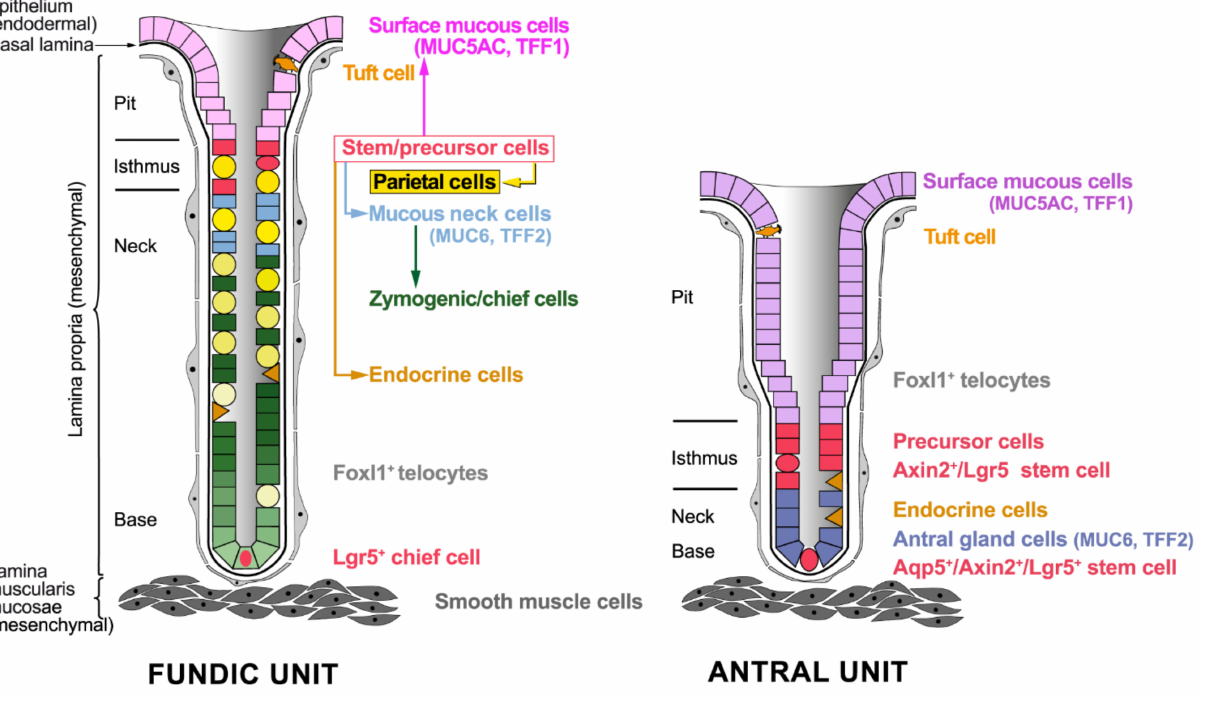
Figure 1. Schematic representation of the gastric mucosa and the two gross types of gastric units in the fundus/corpus and cardia, antrum/pylorus, respectively. A gastric unit consists of the pit (or foveola) and the gland (i.e., isthmus, neck, and base). Shown are the major epithelial (surface mucous, parietal, mucous neck, zymogenic/chief, endocrine, and antral gland cells) and mesenchymal cell types (Foxl1 + subepithelial telocytes, smooth muscle cells). The various gastric stem and precursor cells are marked in red. Additionally, figured are rare tuft cells in the pit regions of both